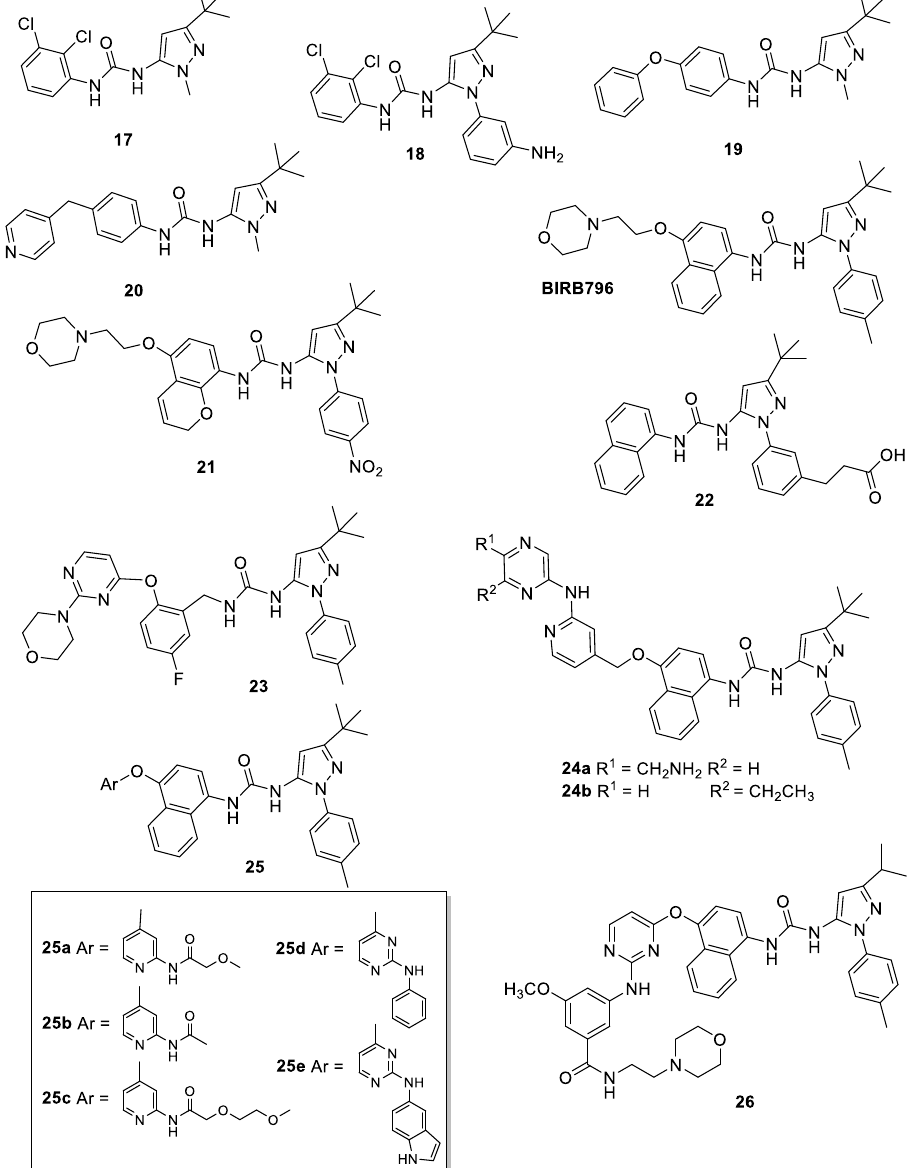
Figure 4. 5-Pyrazolyl-ureas reported as p38 inhibitors.